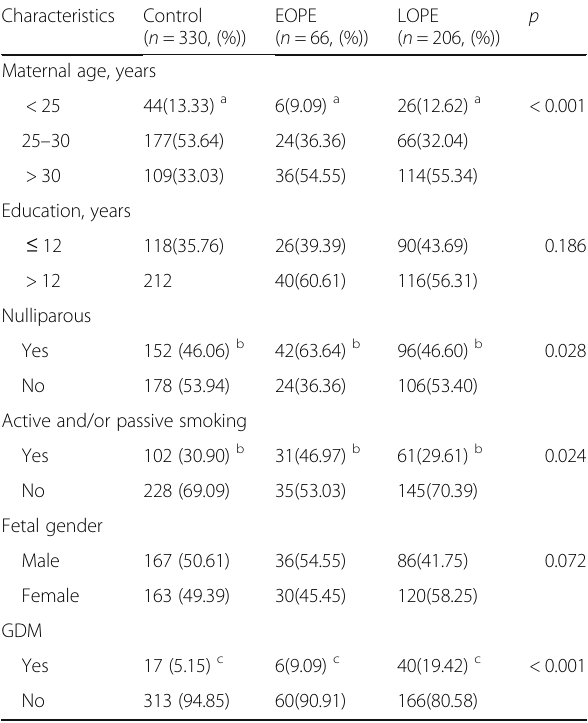
Table 1 Distributions of characteristics between selected PE patients and Controls